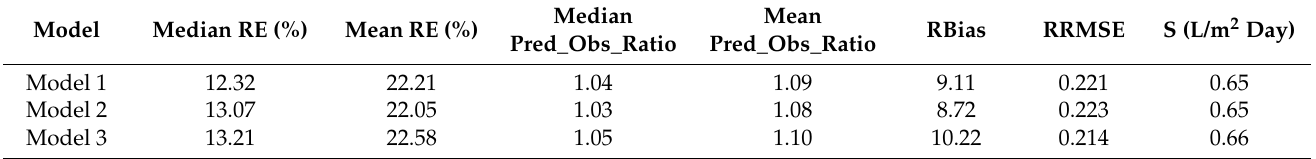
Table 8 compiles model statistics for Models 1, 2, and 3 for the mod-still. The lowest median RE% is found for Model 1 whereas the mean RE% is seen for Model 2. In terms of median predicted to observed ratio values, Model 2 outperforms Model 1 and Model 3. In terms of RBias, Model 2 is also the best performer. In terms of RRMSE (relative root mean squared error) and S , all the three models perform equally. Since Model 2 has the lowest values for mean relative error, median and mean predicted versus observed ratio, relative bias and RBias and the standard error of estimate, it is considered to be the best model among the three models for the mod-still. Table 8. Comparison of model statistics for Models 1, 2, and 3